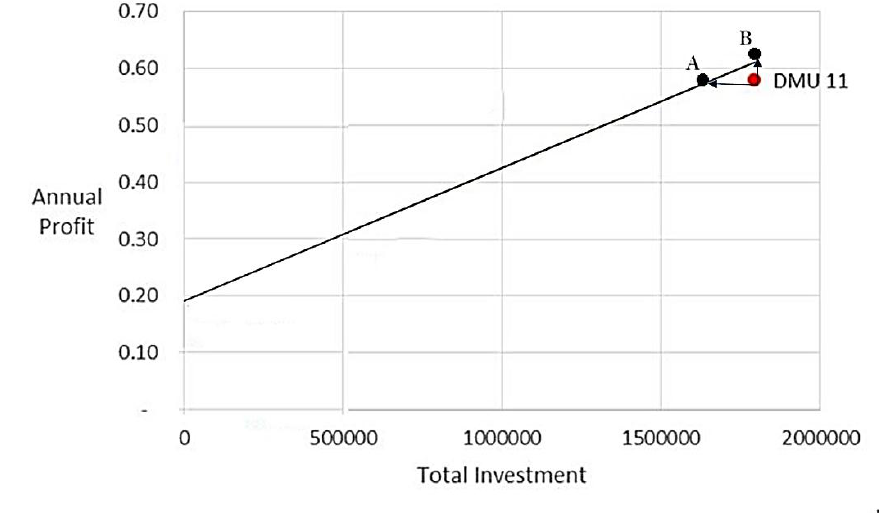
Figure 8. Improved State of DMU